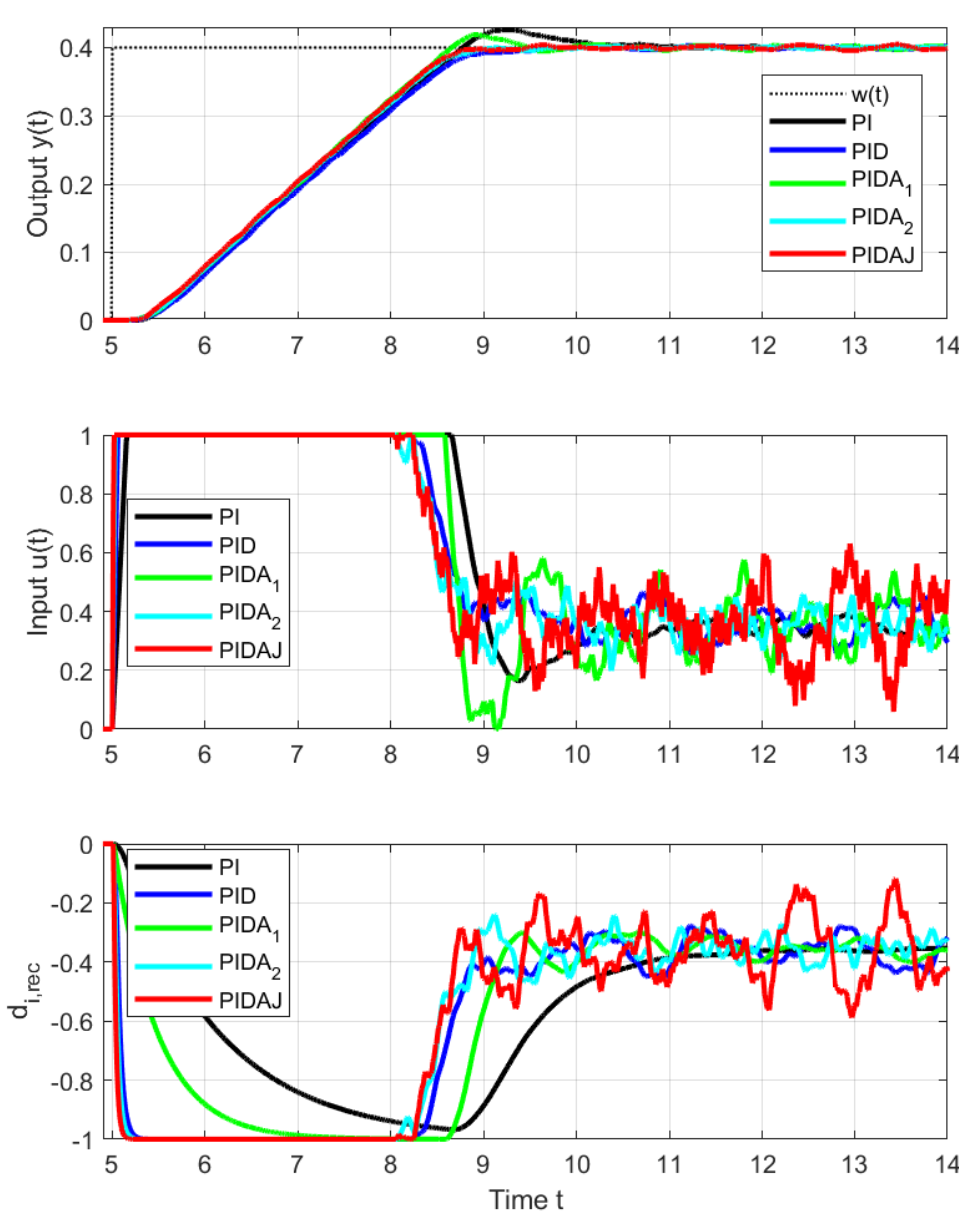
Figure 5. Details of setpoint step responses from w = 0 to w = 0.4 at t = 5